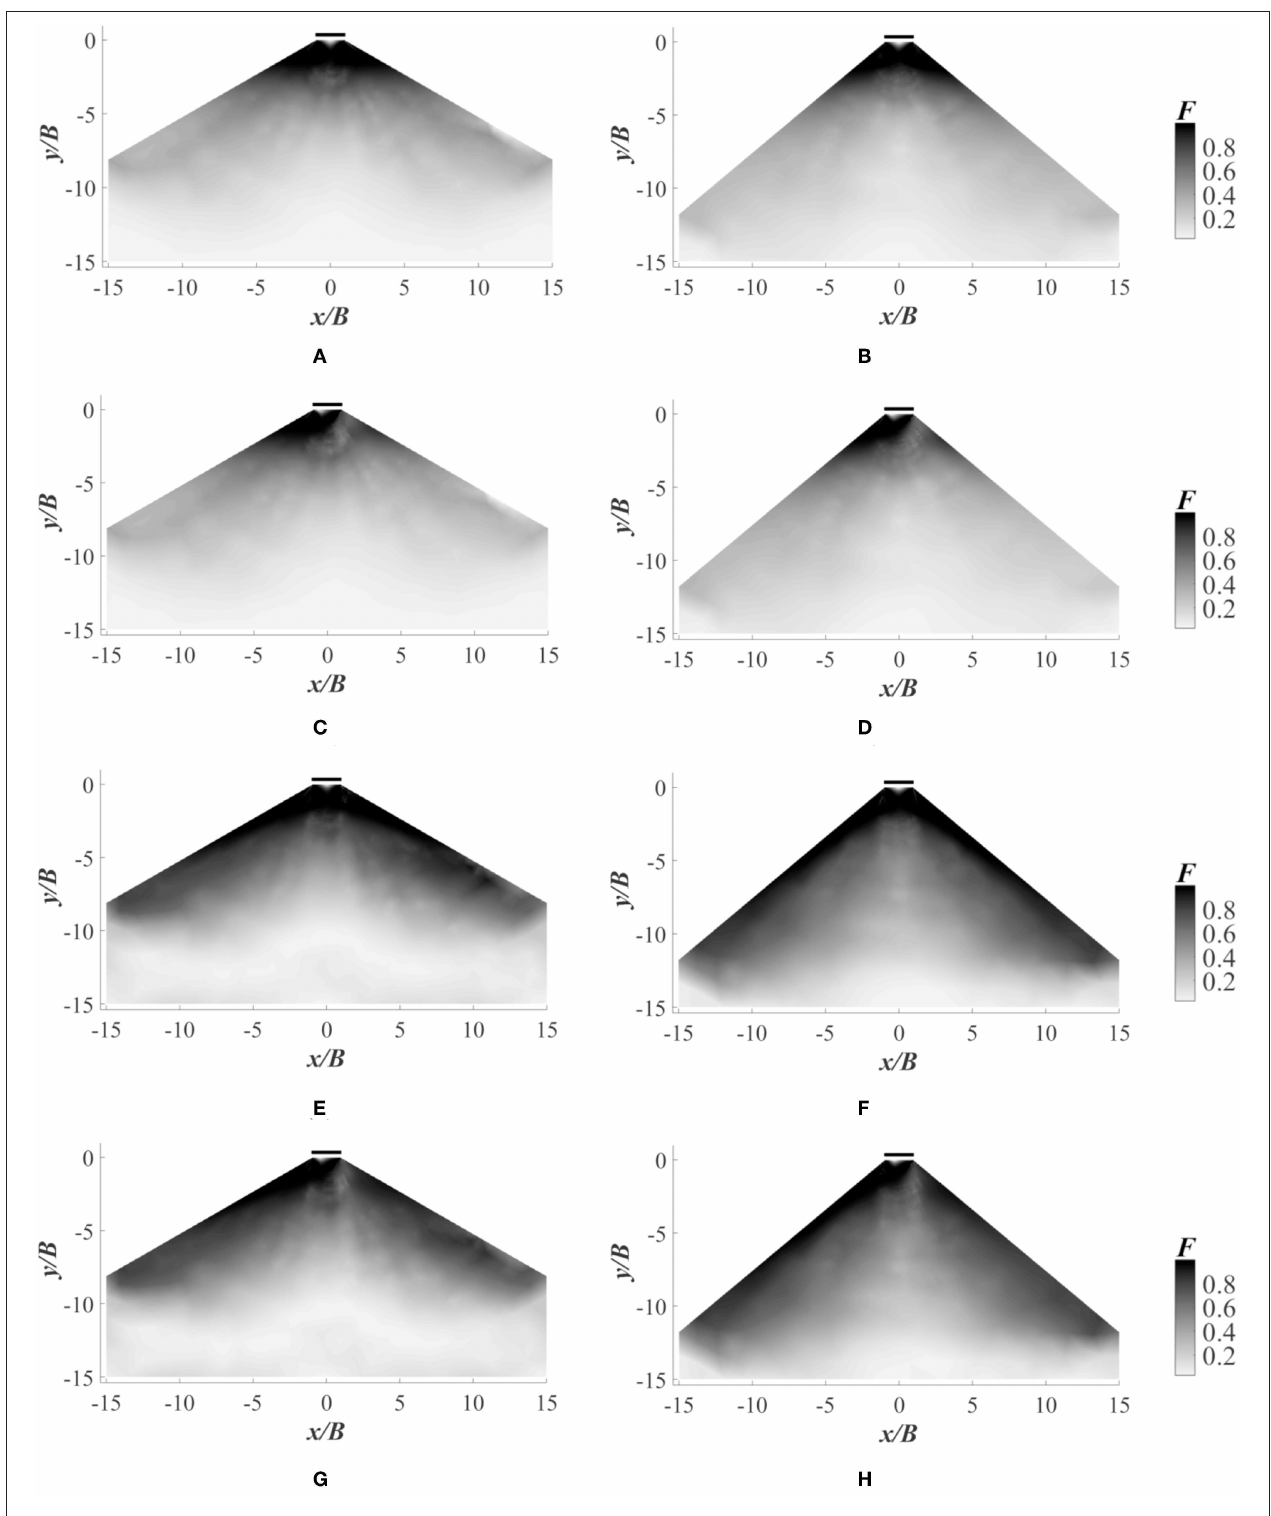
FIGURE 5 | Failure contours for S/B for S/B